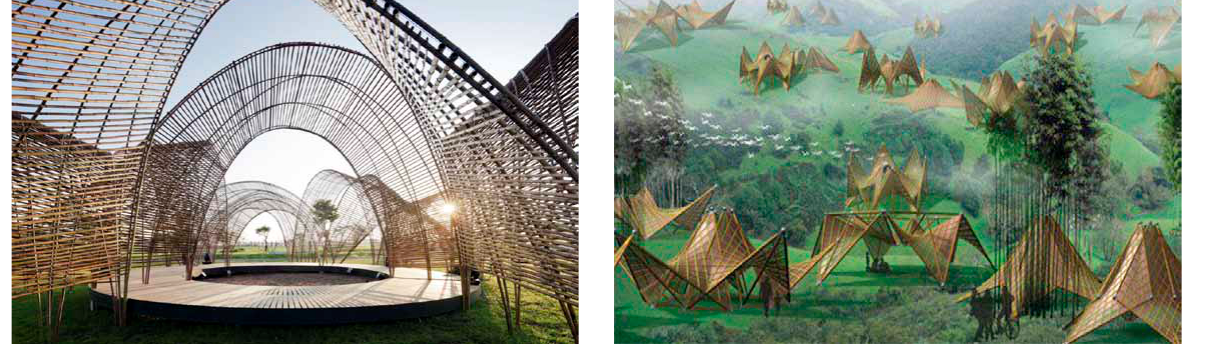
fig. 1. forest Pavilion by narchitect (source: http://www. fig. 2. folded Bamboo House by Ming Tang (Basulto